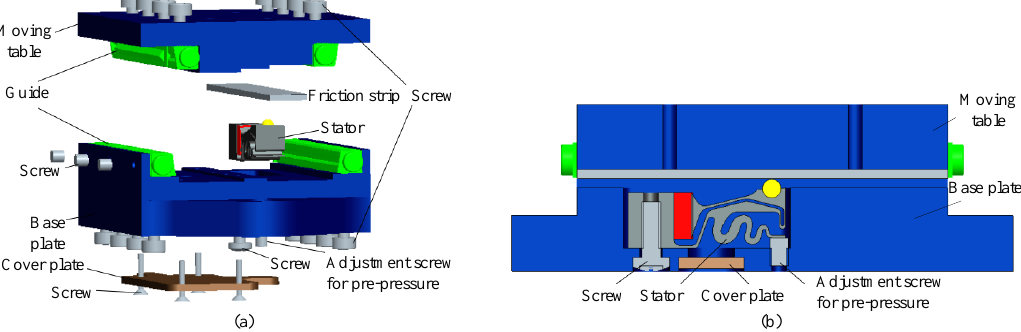
Figure 2. Configuration of the stage. ( a ) Structural explosion diagram of the stage. ( b ) Side view of the stage.